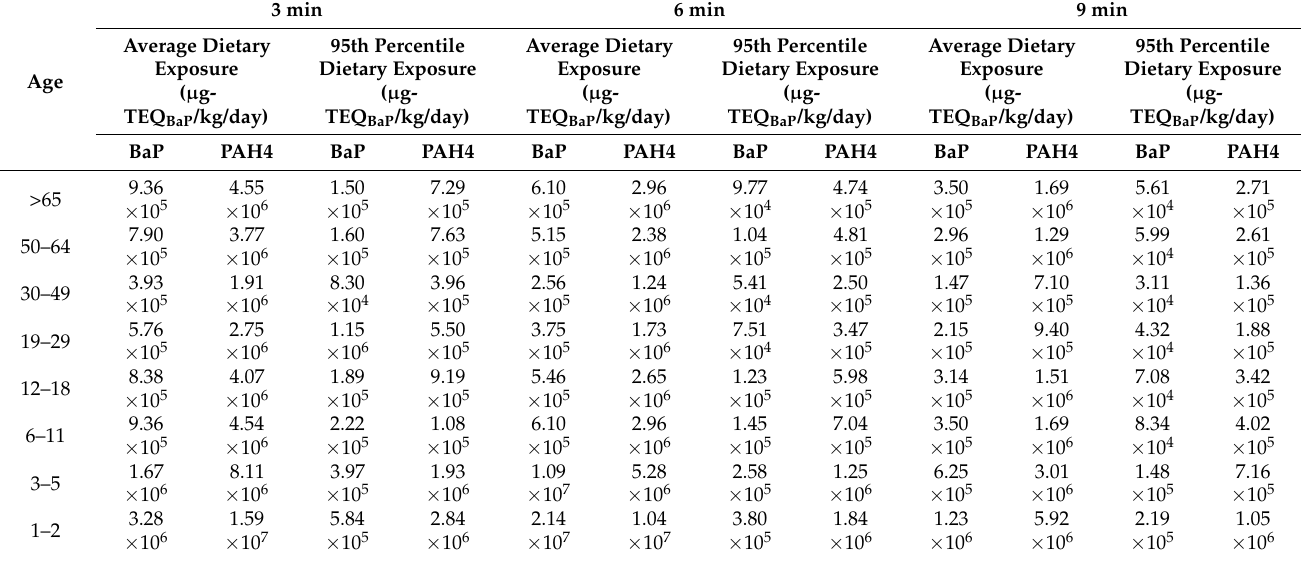
Table 5. Variation of MOE value by frying time for each age group.